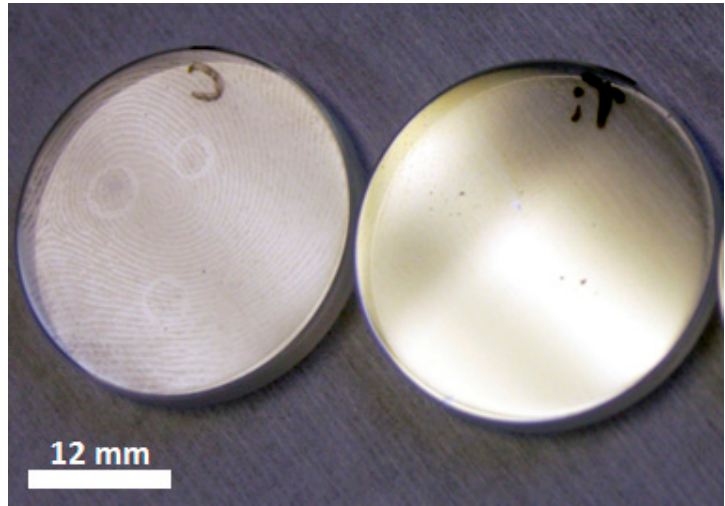
Figure 2. Photographic comparison of the fingerprint removal study on a sapphire window ( left ) and an anatase coated sapphire window ( right ), following treatment with 365 nm UV exposure for 24 h in air.